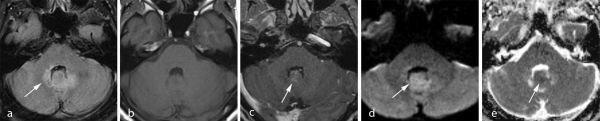
MR images at the time of diagnosis. T2 fluid-attenuated inversion recovery image on which the abnormal T2 hyperintense signal on the dorsolateral side of the fourth ventricle and hyperintense nodulus of the vermis can be appreciated (a, arrow). Being isointense to surrounding white matter on T1 weighted images (b) the area showed subtle, nodular-like contrast enhancement (arrows in T1 weighted postcontrast image c). Diffusion-weighted imaging showed subtle diffusion restriction (arrows in d (diffusion-weighted image) and e (apparent diffusion coefficient map)).